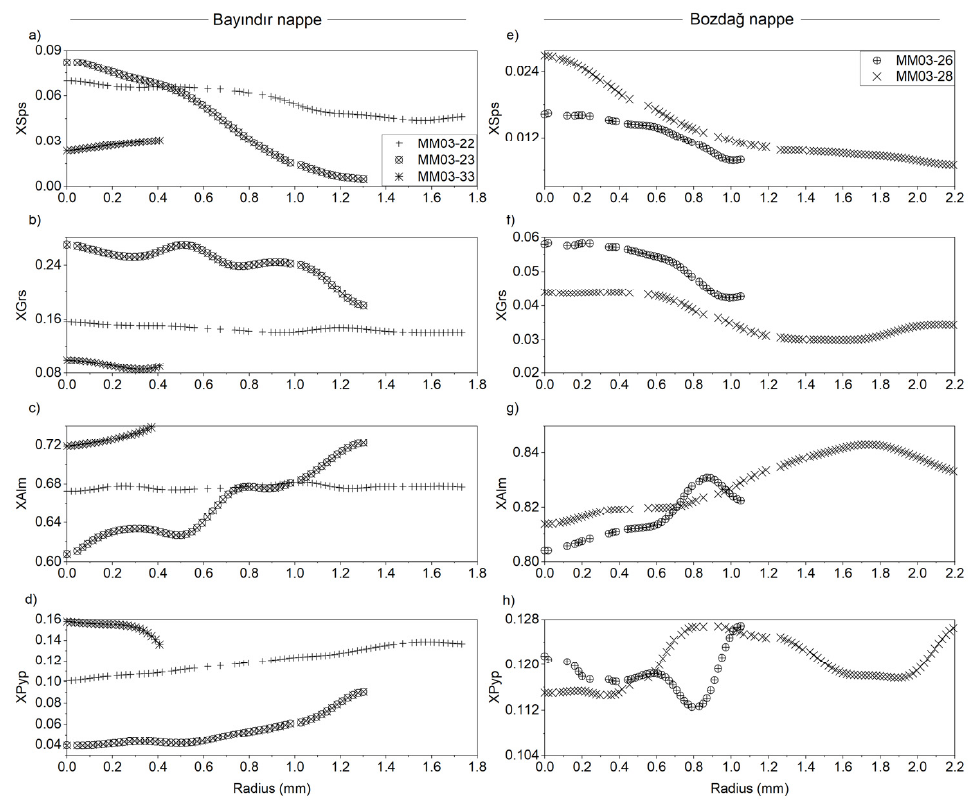
Figure 8. Garnet compositions from select samples from the Central Menderes Massif [23]. Data are plotted as individual garnet mole-fraction end-member (spessartine, grossular, almandine, pyrope). Panels ( a – d ) are from Bayındır nappe samples MM03-22, 23, and 33. Panels ( e – h ) are from Bozdağ nappe samples MM03-26 and 28.